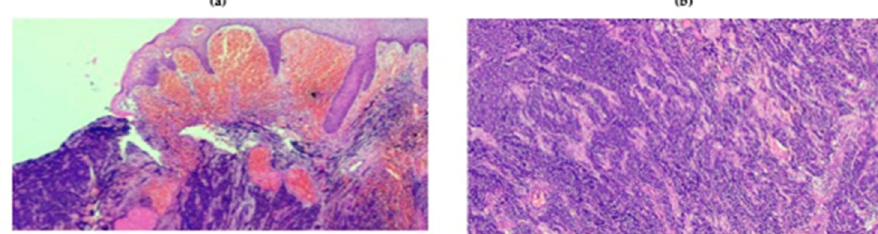
Figure 5. Representative histologic patterns from MCC. ( a , b ) Histology of MCC characterized by deep infiltration of the dermis by lymphocytes at 4 × ( a ) and 10 × ( b ) magnification.